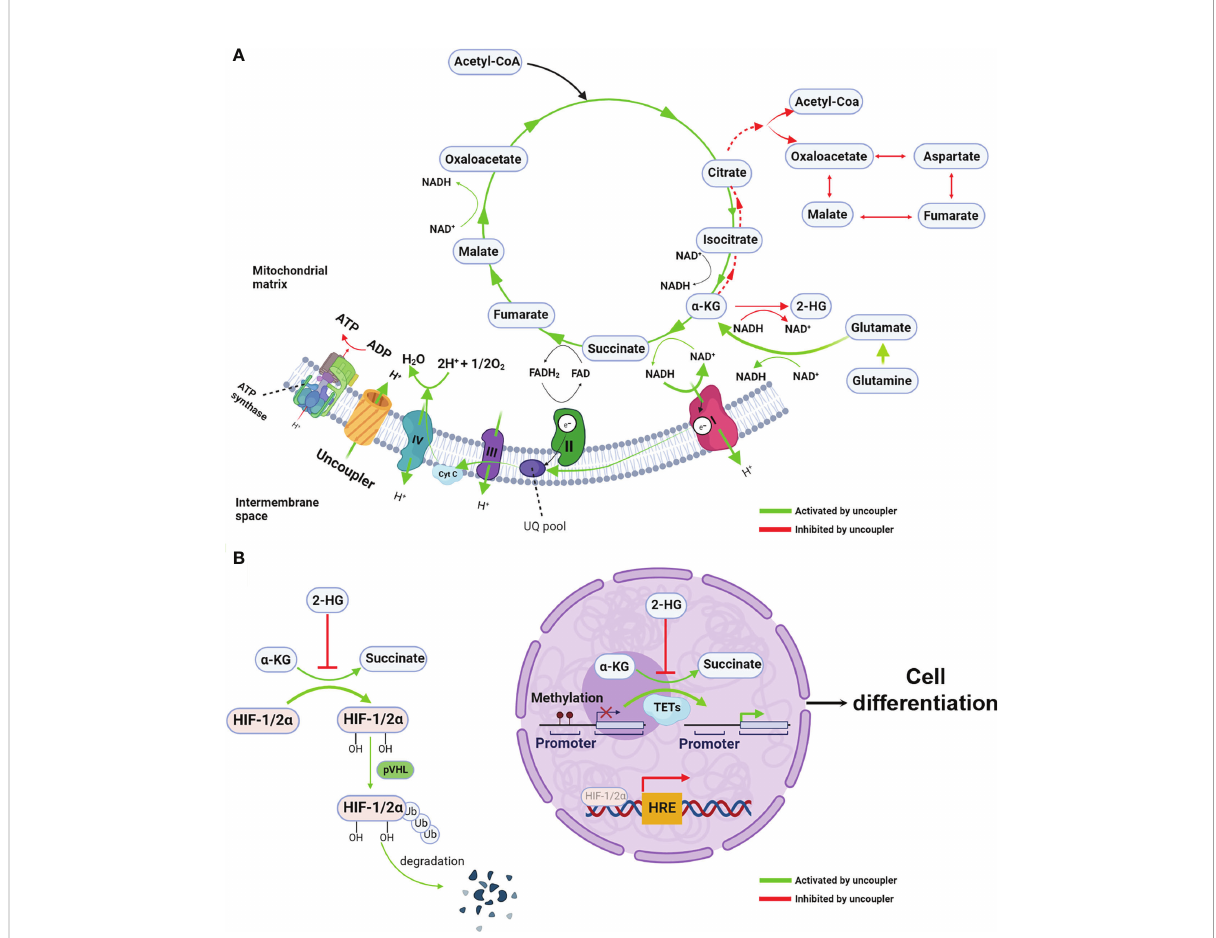
FIGURE 2 Mitochondrial uncoupling reprograms metabolism and epigenetic landscape (A) Mitochondrial uncouplers dissipate the proton gradients which are essential to ATP synthesis, resulting in reduction of ATP/ADP ratio. When proton gradient reduce, the electron transfer chain, particularly complex I, are activated, leading to increased intracellular redox NAD + /NADH ratio. Given the NAD + /NADH ratio is the major driving force for TCA cycle, the oxidative TCA cycle and glutaminolysis are accelerated. Because the chemical equilibrium of many metabolites pair such as a - KG/2-HG and pyruvate and lactate (not show in the fi gure) are dictating by NAD + /NADH ratio. Thus, increased NAD + /NADH mediated by mitochondrial uncoupler shift the equilibrium from 2-HG to a -KG, resulting in increased a -KG/2-HG ratio. In the other hand, opposite to the oxidative TCA cycle, the reductive TCA cycle particular reductive carboxylation is inhibited by mitochondrial uncoupler. (B) The increased a -KG/ 2-HG ratio activates the a -KG-dependent dioxygenases such as TET and PHD, leading to DNA demethylation and HIFs protein degradation. These epigenetic rewiring activate the expression of differentiation makers and repress the stemness genes, consequently, cell differentiation. Created with